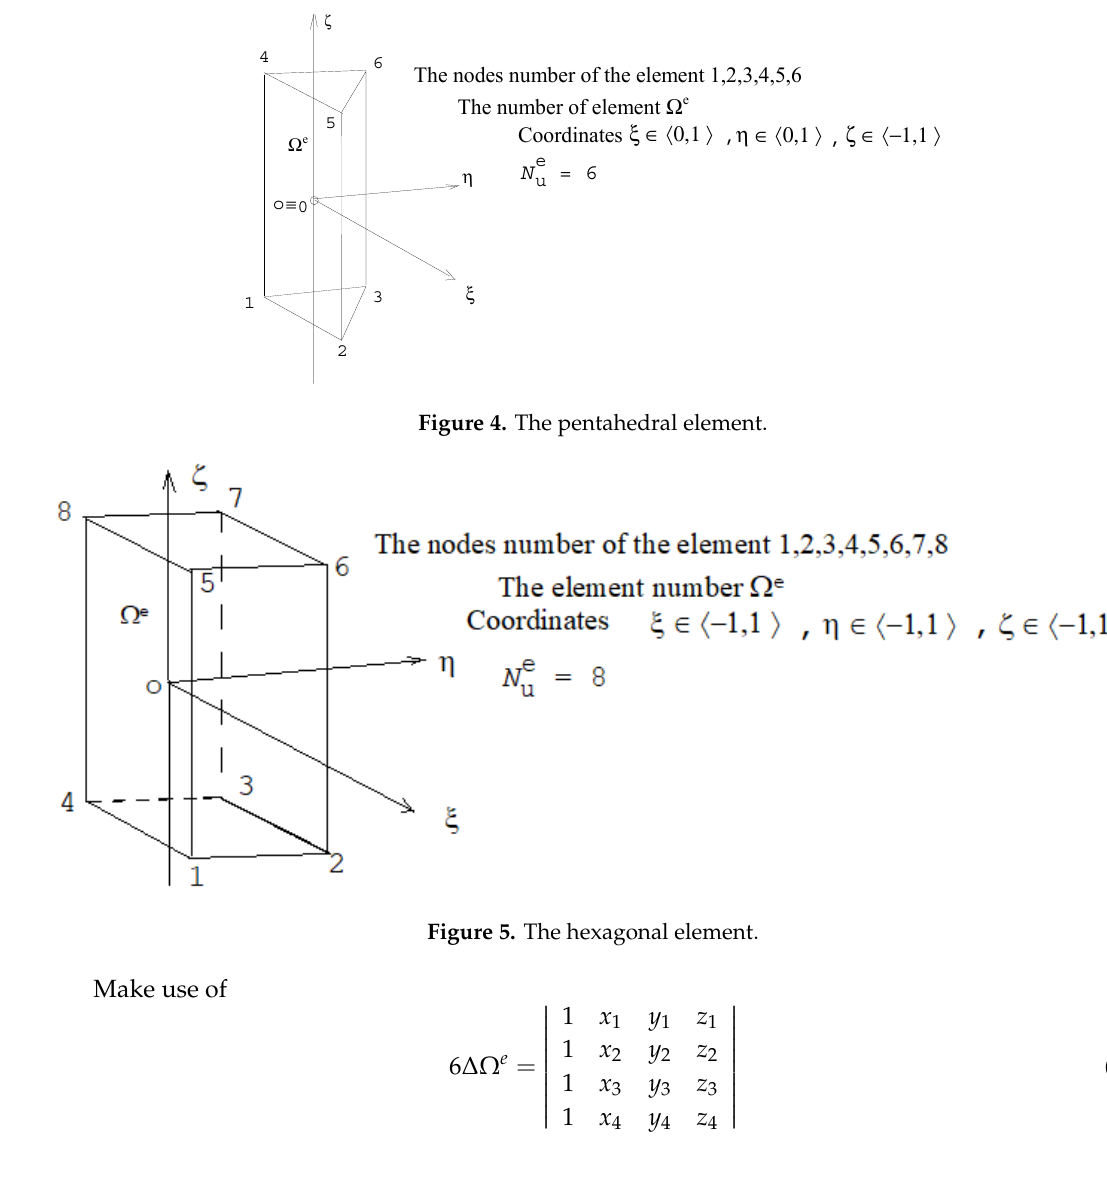
Figure 3. The tetrahedral element and its symbolic description.